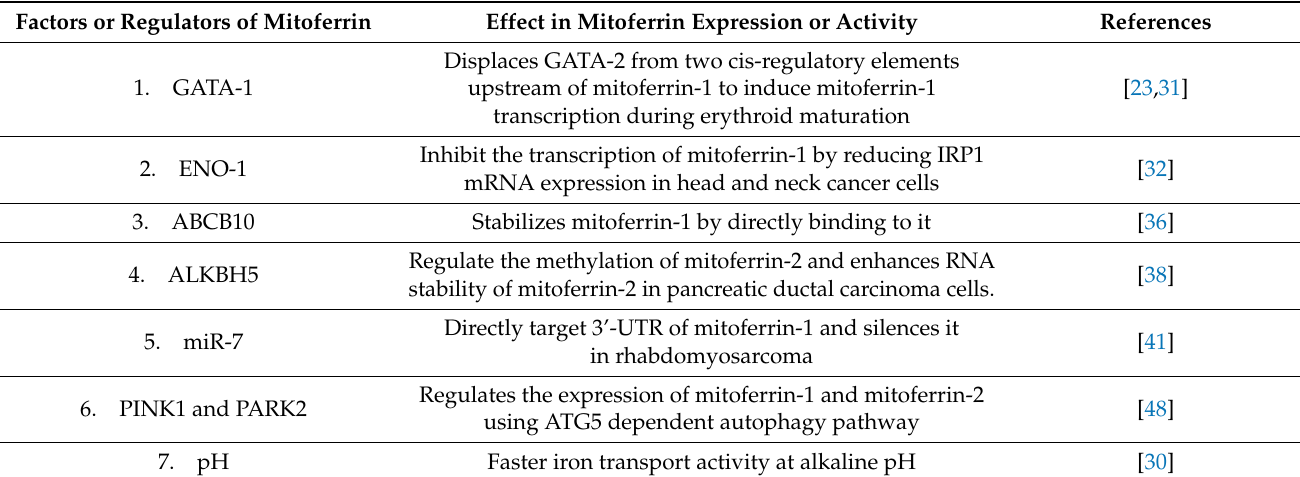
Table 2. Summary of factors and regulators regulating mitoferrin expression and iron transport